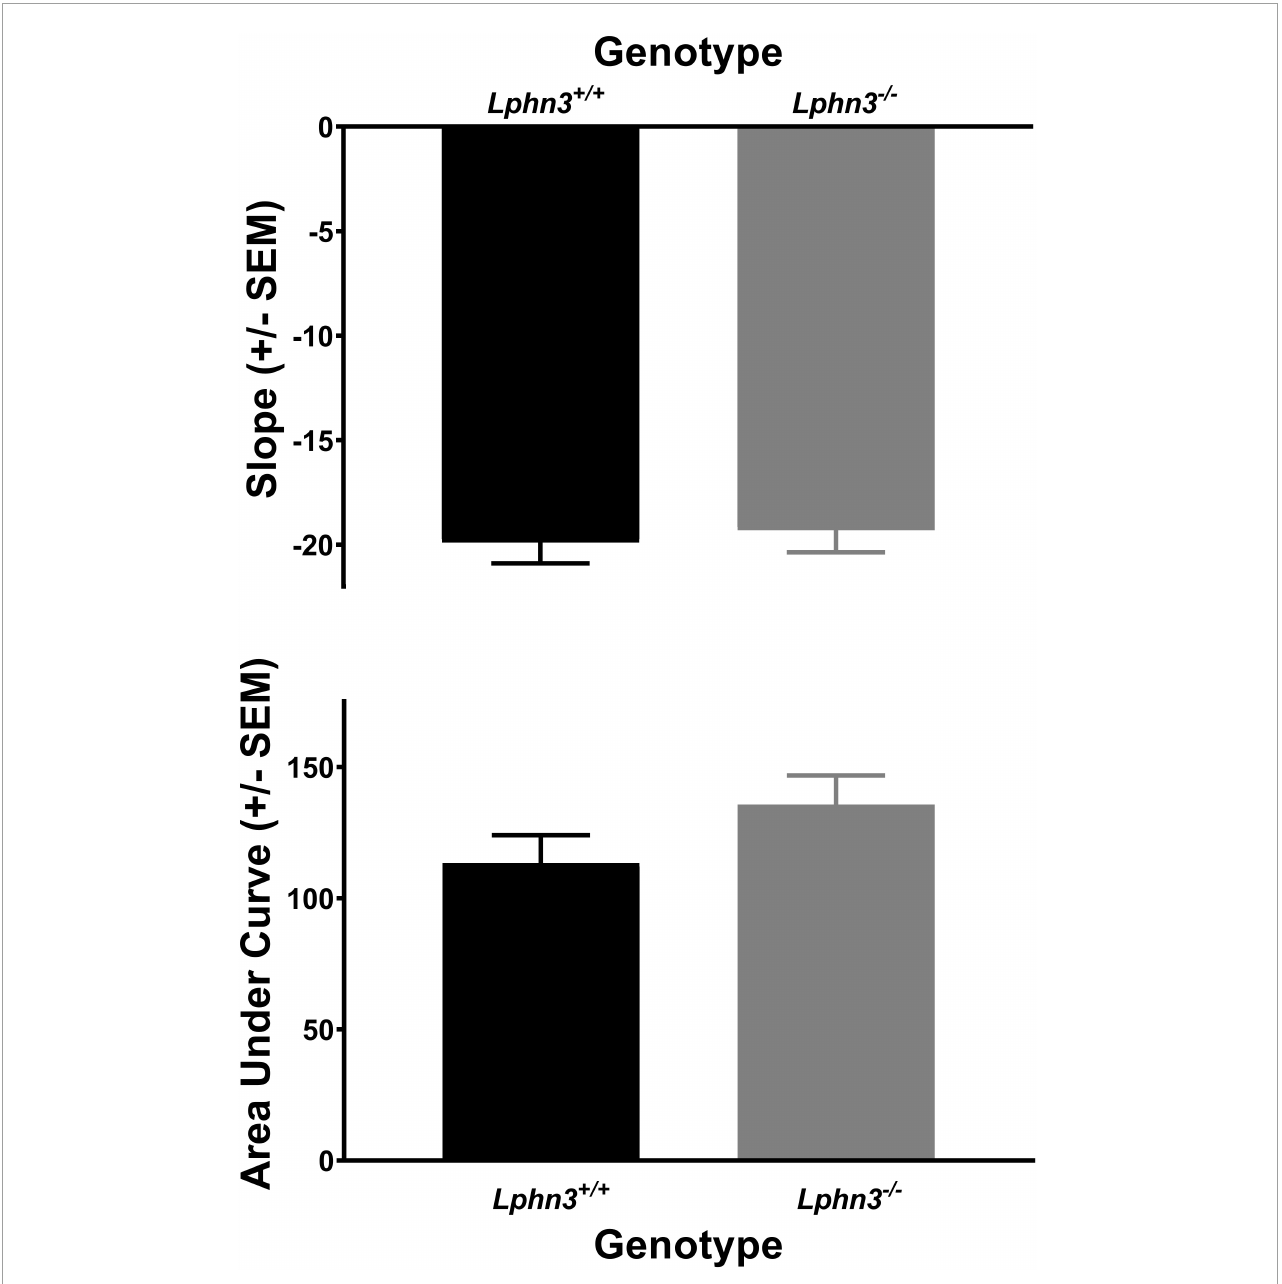
FIGURE6 The slope of the discounting curve (top) and area under the discounting curve (bottom) did not differ between the Lphn3 − / − (knockout) and Lphn3 + / + (wildtype) rats when trial lengths were not equal.